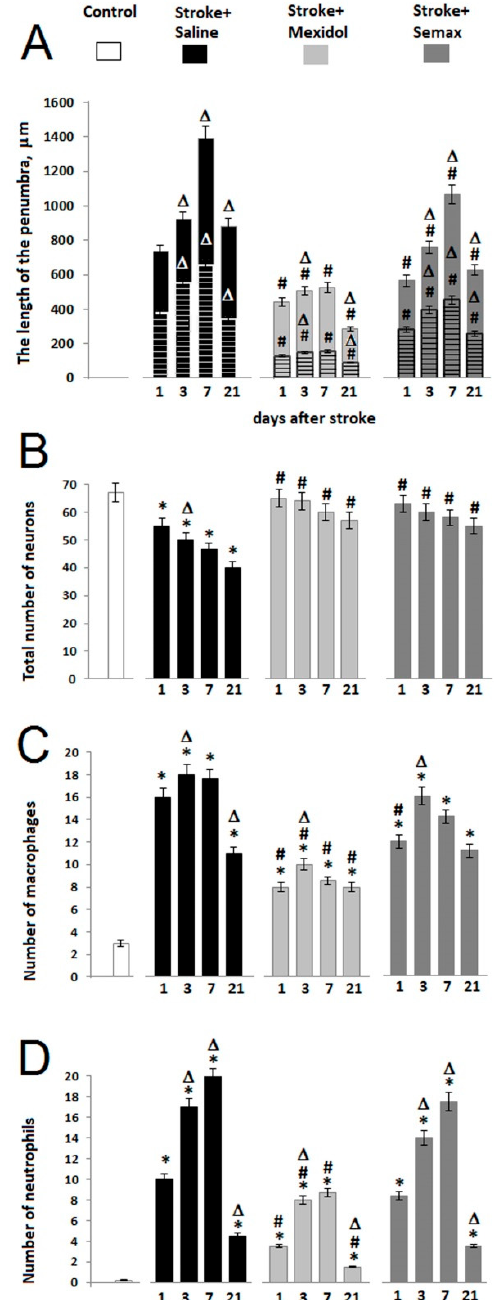
Figure 5. Effects of a 7-day Mexidol and Semax treatment course on the cellular composition of the penumbral zone at 1, 3, 7, and 21 days after PT. The diagram represents the quantitation of ( A ) the length of the penumbra, ( B ) neurons, ( C ) macrophages, and ( D ) neutrophils as the mean ± SEM. For Diagram A, the length (the distribution depth) of the central most extended site of the penumbra is represented by unhatched bars, while the lengths of the lateral sites are represented by the hatched bars. The experiments used six randomized microphotographs (images corresponding to the area of a penumbra of 0.1 mm 2 ) of three slices from four rats. * p < 0.05 denotes a significant difference from the Control group; # p < 0.05 denotes a significant difference from the Stroke + Saline group in the same time period; Δ p < 0.05 denotes a significant difference from the previous observation time point based on a two-way ANOVA with Bonferroni’s post-hoc multiple comparison test.